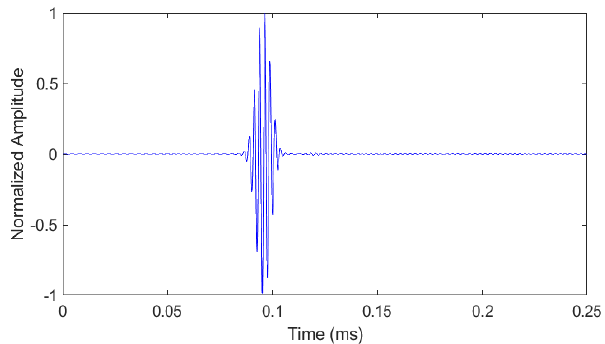
Figure 10. Time plot of an arbitrary atom selected from the FEM simulation dictionary.